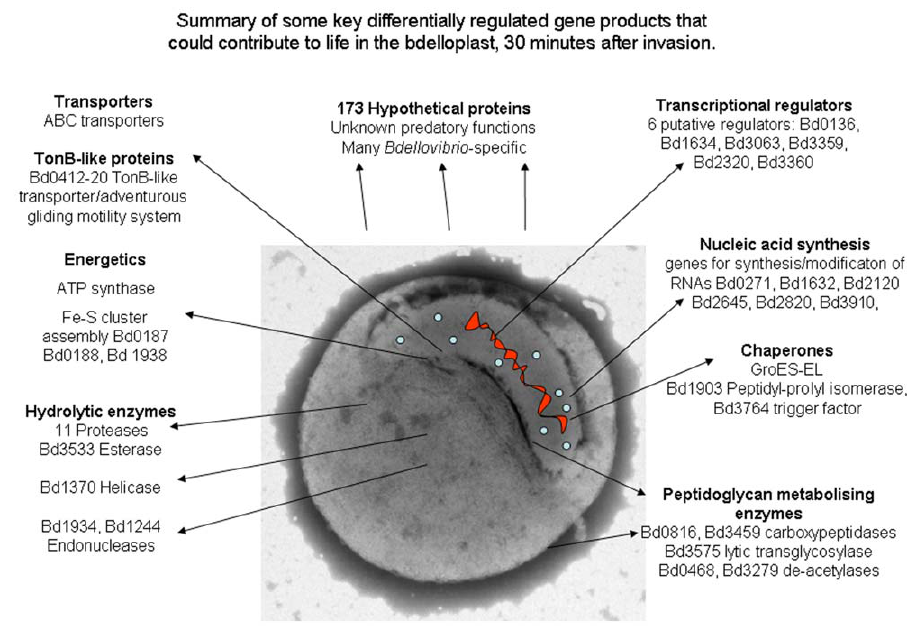
Figure 8. Gene expression key to 30 minutes predation. Visual summaries of key gene expression characteristics at 30 minutes of predatory growth by Bdellovibrio cells, as implied by genes highly expressed in the predatory dataset, but downregulated in the other two